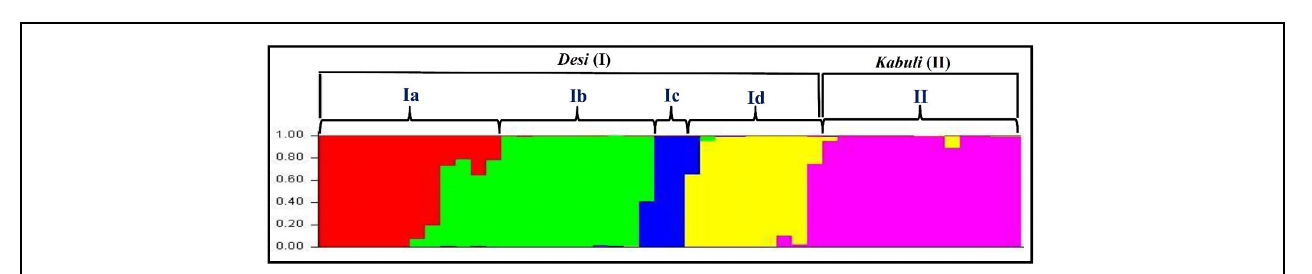
markers in 31 desi and 15 kabuli chickpea genotypes. Molecular classification clearly differentiated genotypes into six different clusters, which corresponded to their cultivar-specific origin and parentage/known pedigree relationships.